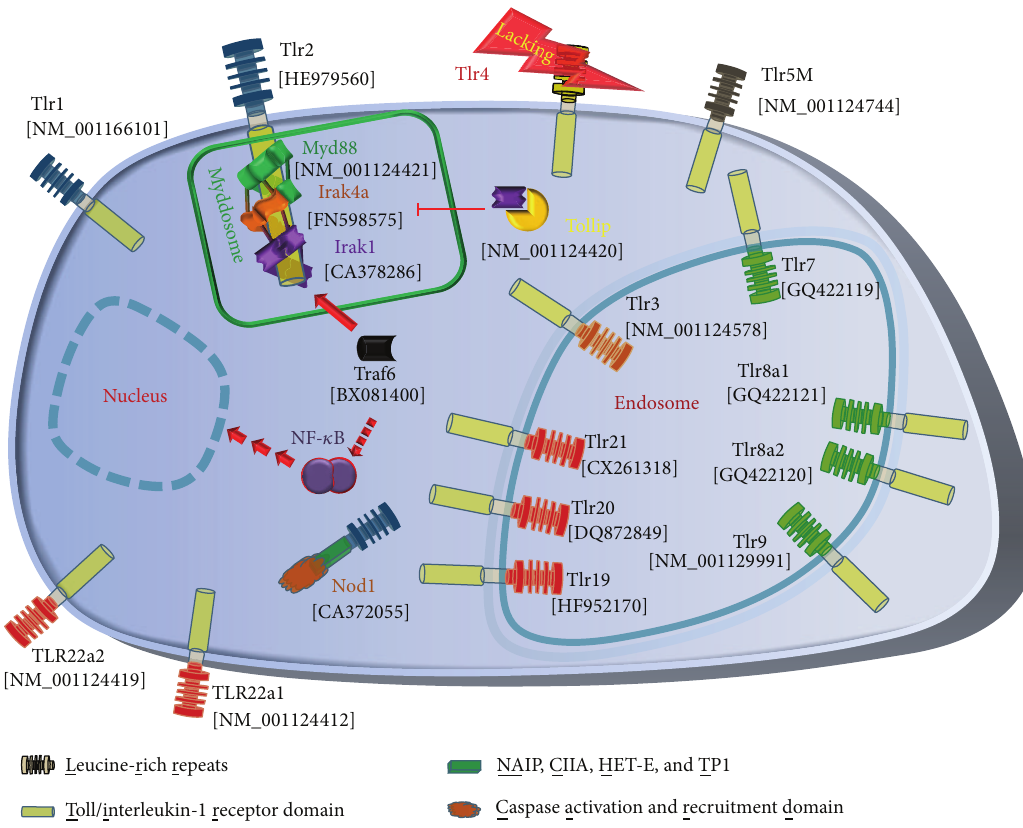
Figure 1: Pathogen recognition in trout. Toll-like receptors, Nod1, and downstream factors as known from trout are listed with their GenBank accession numbers. Different colors of the LRR regions factors indicate the membership to individual Tlr families (TLR1 (blue), Tlr3 (orange), Tlr5 (black), Tlr7 (green), and Tlr11 (red)). Notably, a Tlr4 ortholog is absent in salmonid fish (marked with a flash). The Myddosome consisting of Myd88, Irak4a, and Irak1 (inside the green box) binds to the activated Tlr and recruits Traf6 and further downstream factors (indicated with a broken arrow), which in turn activate NF- 𝜅 B. Tollip functionally inhibits Irak1 by preventing its recruitment into the Myddosome